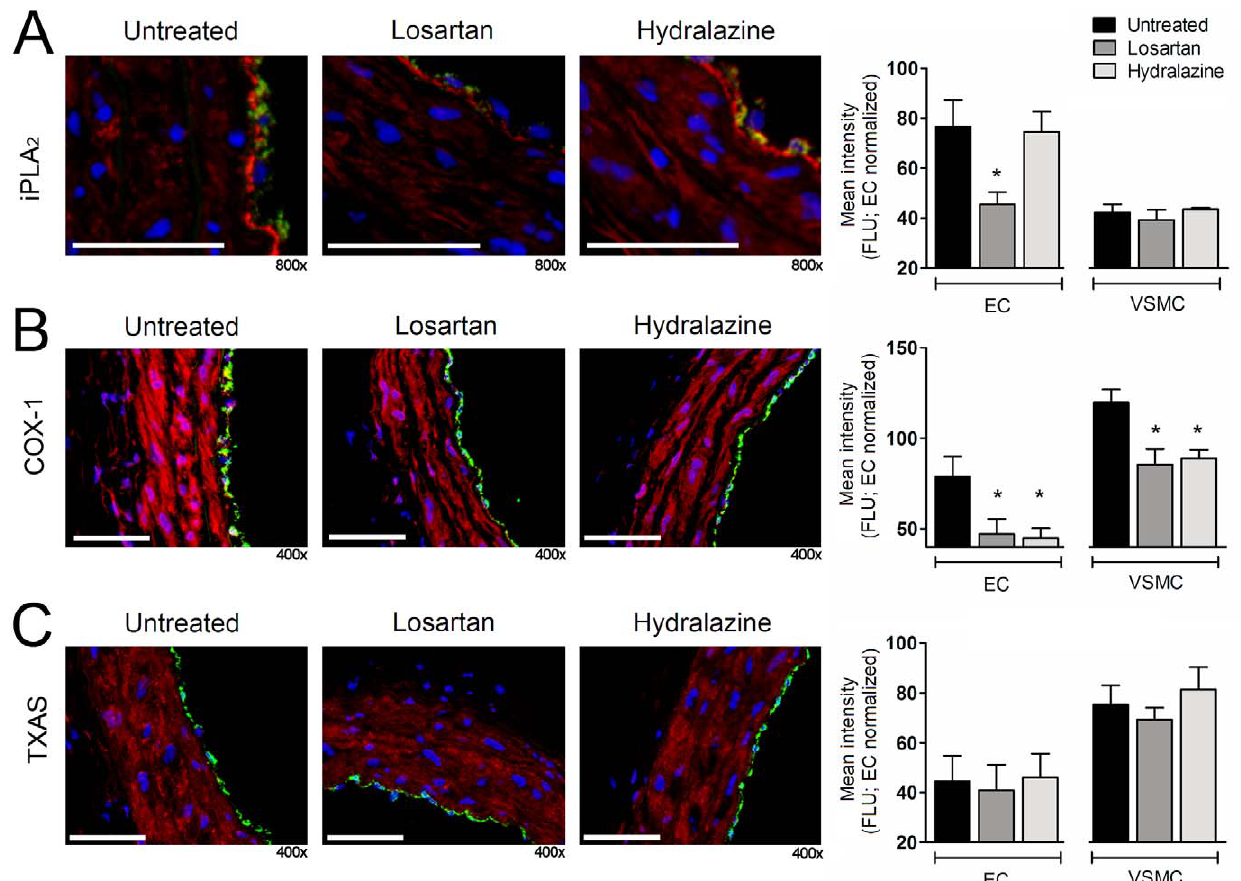
Figure 5. Losartan but not hydralazine reduces endothelial iPLA 2 expression. ( A ) Immunohistochemical staining (left) and quantification (right) of SHR carotid artery segments depicting cell nuclei staining (blue), with the von Willebrand Factor (vWF) endothelium marker (green) and calcium-independent phospholipase A 2 (iPLA 2 ; red), ( B ) cyclooxygenase-1 (COX-1; red), ( C ) thromboxane synthase (TXAS; red). Scale bars represent 100 m m. Data are expressed as mean 6 SEM, n=7–8, * p , 0.05 compared to untreated